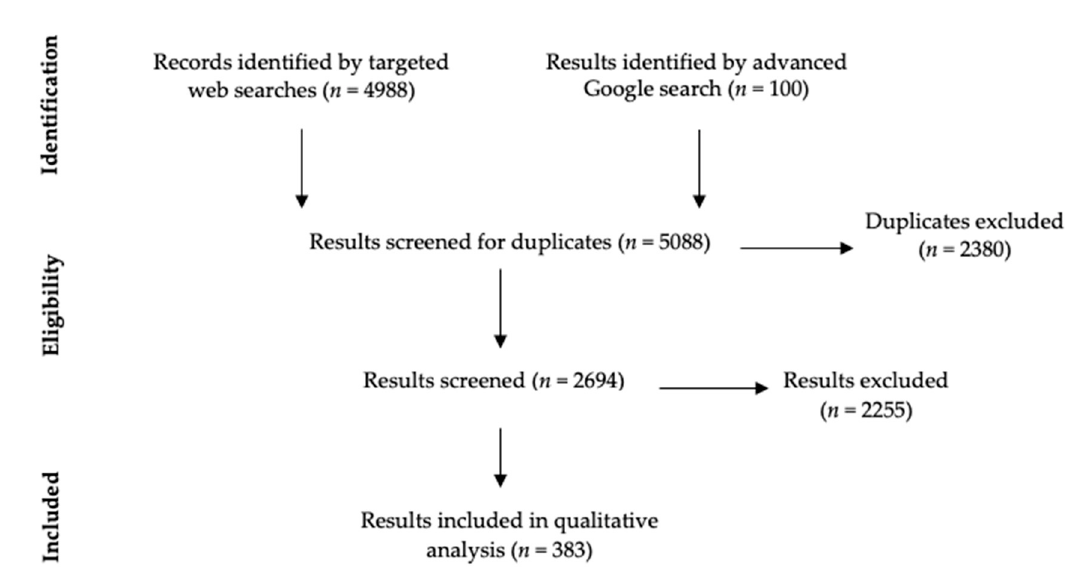
Figure 1. PRISMA Flow Diagram.